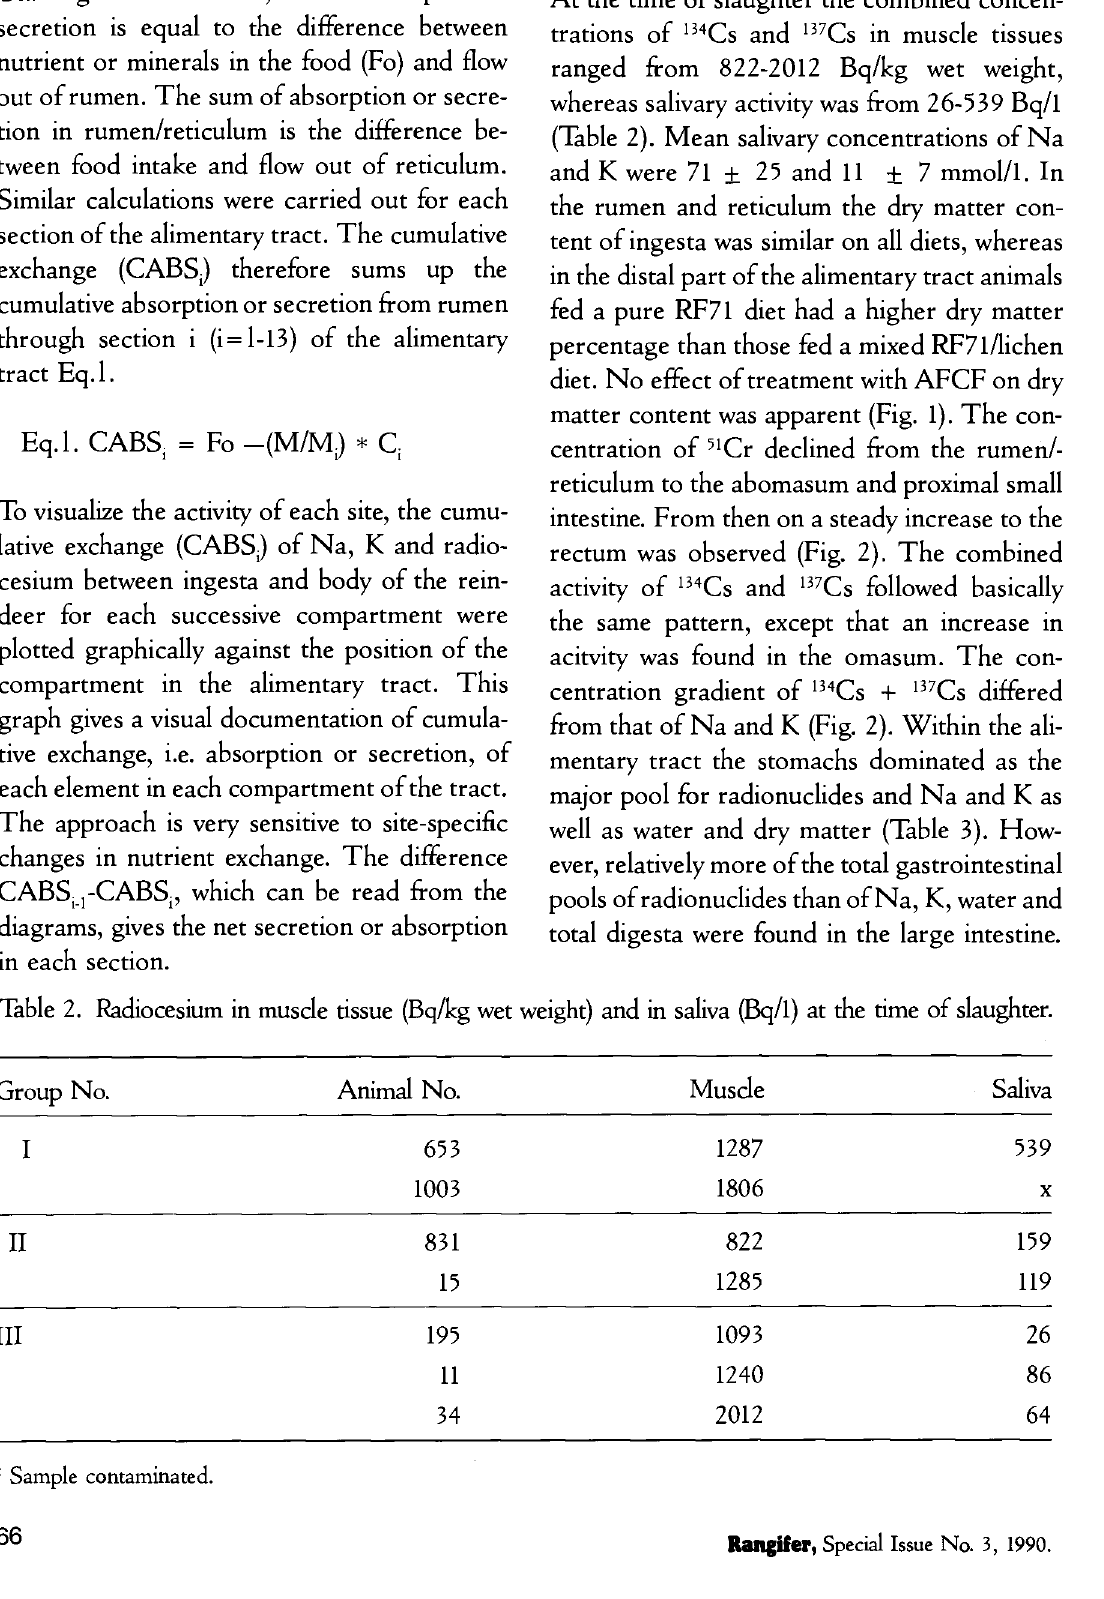
Table 2. Radiocesium in muscle tissue (Bq/kg wet weight) and in saliva (Bq/1) at the time of slaughter.